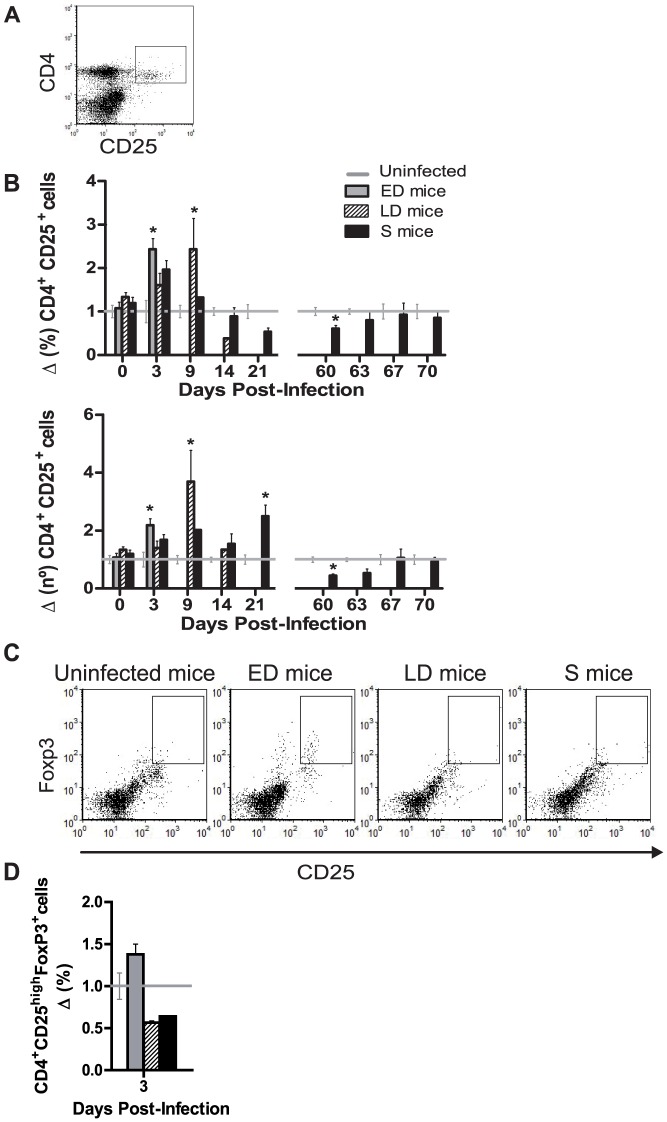
CD4+ CD25+cells in blood of PyL infected mice.ICR mice infected with 2×107
PyL iRBCs were classified as early deceased (ED), late deceased (LD) or surviving (S) depending on the infection profiles. Survivors were reinfected on day 60 pi. Blood leukocytes from each mouse were isolated and (A) CD4+ CD25+ cells were detected by flow cytometry. (B) Proportions with respect to total leukocytes and absolute numbers recorded in ED mice, LD mice and S mice were normalized to the data recorded in uninfected mice (n = 5 per experiment). Standard values of CD4+ CD25+ cells were 1.90±0.10×105 cells per ml of blood in healthy mice. * p<0.05 with respect to uninfected mice. (C) Detection of CD25 and intracellular Foxp3 by flow cytometry gated in CD4+ cells. Representative dot plots of the (D) frequency of CD4+CD25highFoxp3+ cells at day 3 pi. Standard proportions of CD25highFoxp3+ cells in CD4+ cells were 1,43±0.15%. Data express mean (± SEM) of 2 independent experiments, each with n>3 mice per time point (except day 14 pi with only one LD mouse).